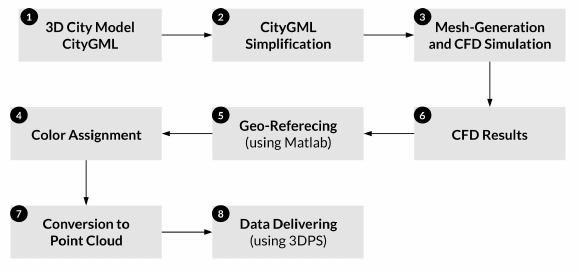
Figure 4. Implementation Step. Numbers correspond to the numbers in the text of Section